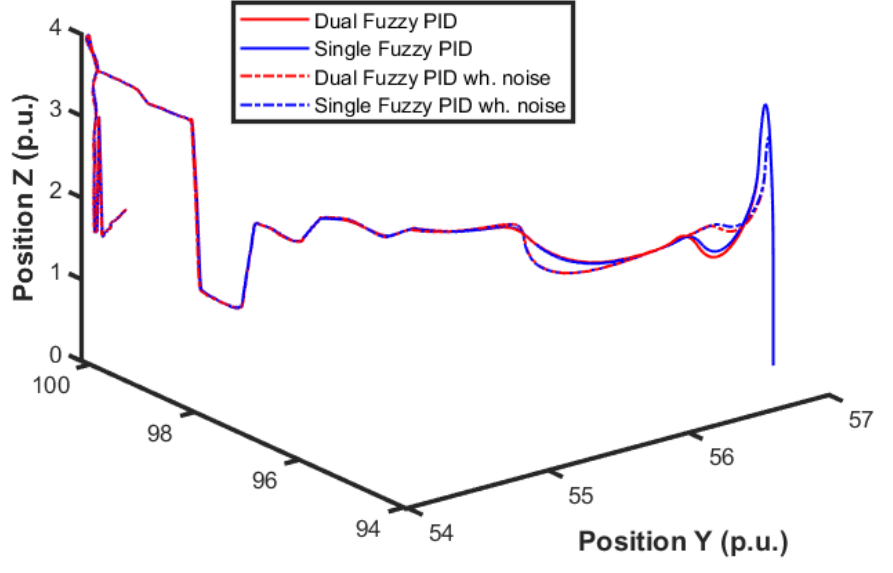
Figure 18. UAV 3D path during